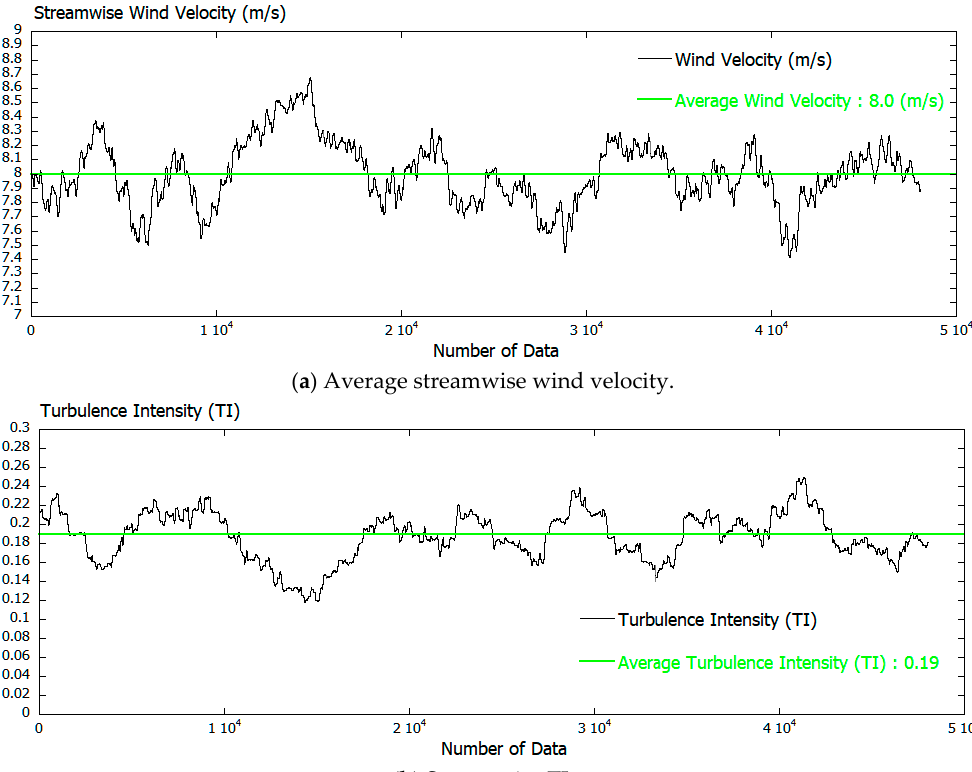
Figure 17. Temporal change of the full-scale streamwise (x) wind velocity (m/s) and TI. Both are calculated by applying a moving-averaged window to the time series data in Figure 15. The data shown are for the hub height (60 m above the ground surface) at T7.